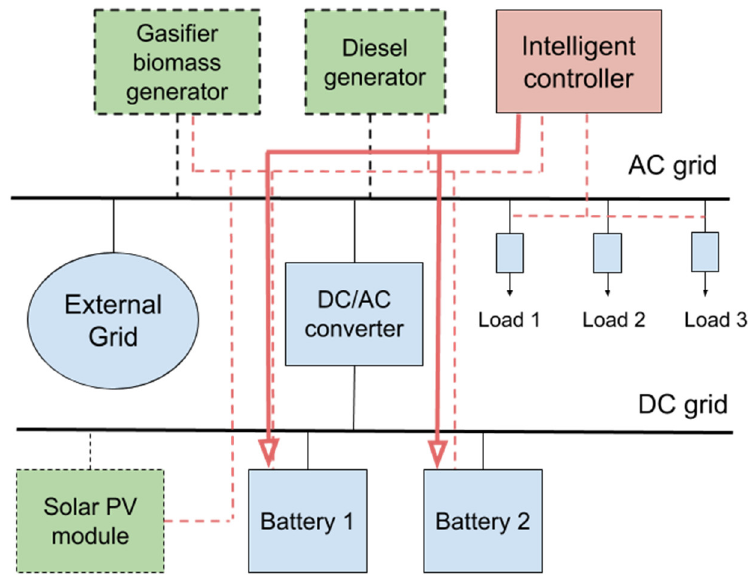
Figure 2. General microgrid configuration. Table 1. Microgrid parameters.